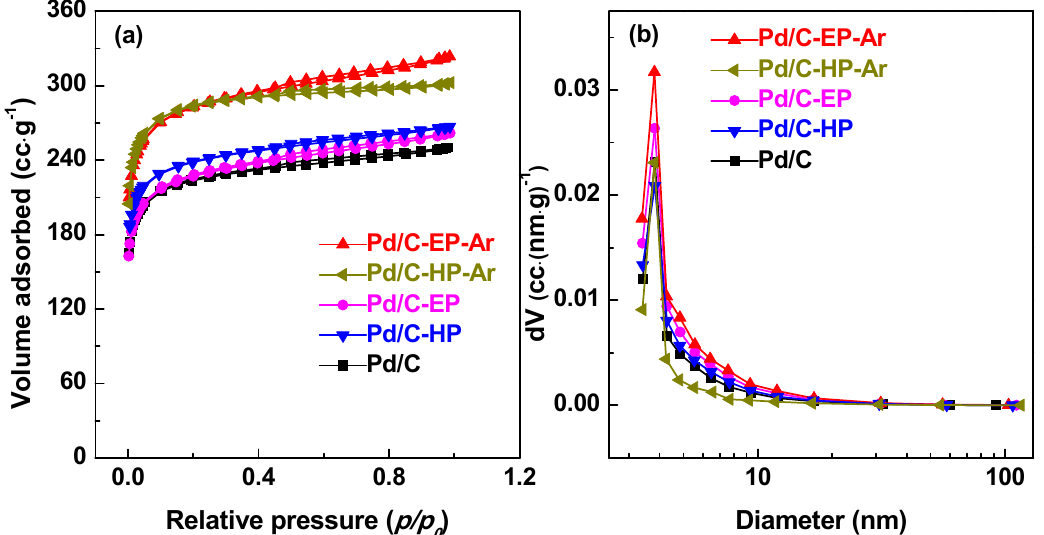
Figure 4. (a) N 2 adsorption–desorption isotherms and ( b ) pore size distributions of Pd/C-EP-Ar, Pd/C-HP-Ar, Pd/C-EP, Pd/C-HP, and